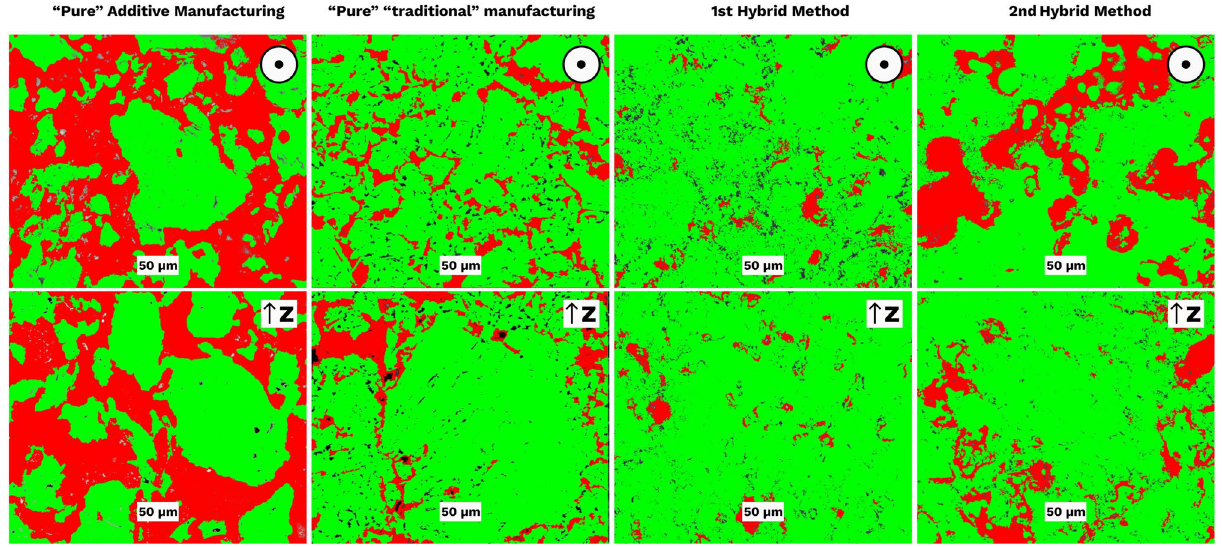
Figure 4. Image analysis of optical microscopy images of crosscuts in XY- and Z-planes. The black arrow points at the build/pressing direction (Z), i.e., perpendicular to the layers; the black circle with the point in the center corresponds to XY plane–parallel to